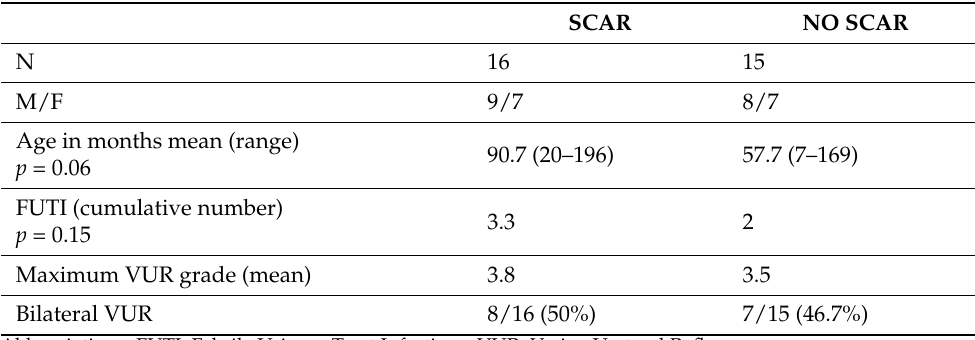
Table 1. Clinico-pathological characteristics of the patients.